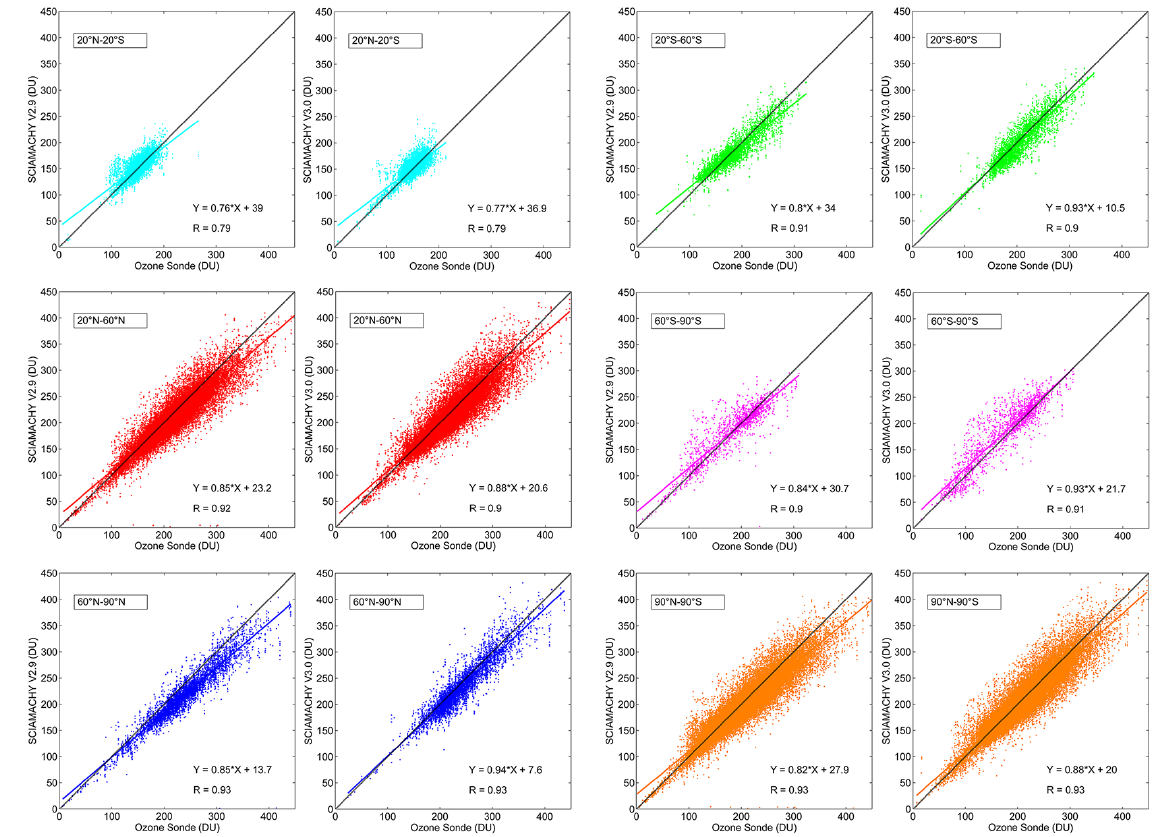
Figure 8. Scatterplots of the partial columns from SCIAMACHY and ozonesonde data within 20 ◦ S–20 ◦ N, 20–60 ◦ N, 60–90 ◦ N, 20–60 ◦ S,